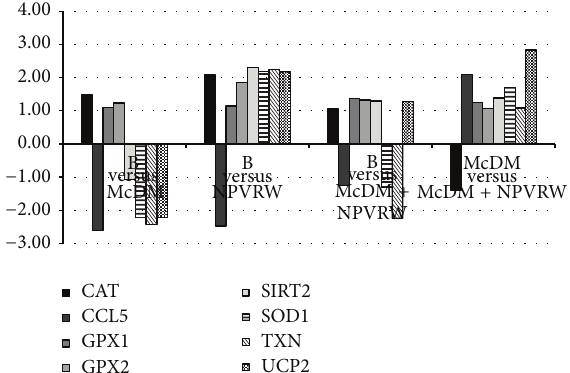
Figure 5: Gene expression in each dietary intervention for oxidative stress pathway. Different levels of up- and downregulation of genes analyzed between McDonald’s meal andMcDonald’s meal with not pruned vineyard red wine. The significant values are expressed as 𝑃 ≤ 0.05 for a level of fold change > ± 2.00. Oxidative stress genes: CAT , Catalase (NM 1752); CCL5 , Copper Chaperone for Superoxide Dismutase (NM 2985); GPX1 , Glutathione Peroxidase 1 (NM 581); GPX2 , Glutathione Peroxidase 1 (gastrointestinal) (NM 2083); SIRT2 , Sirtuin 2 (NM 12237); SOD1 , Superoxide Dismutase 1 Sol- uble (NM 454); TXN , Thioredoxin (NM 3329); UCP2 , Uncoupling Protein 2 (Mitochondrial Proton Carrier) (NM 3355).